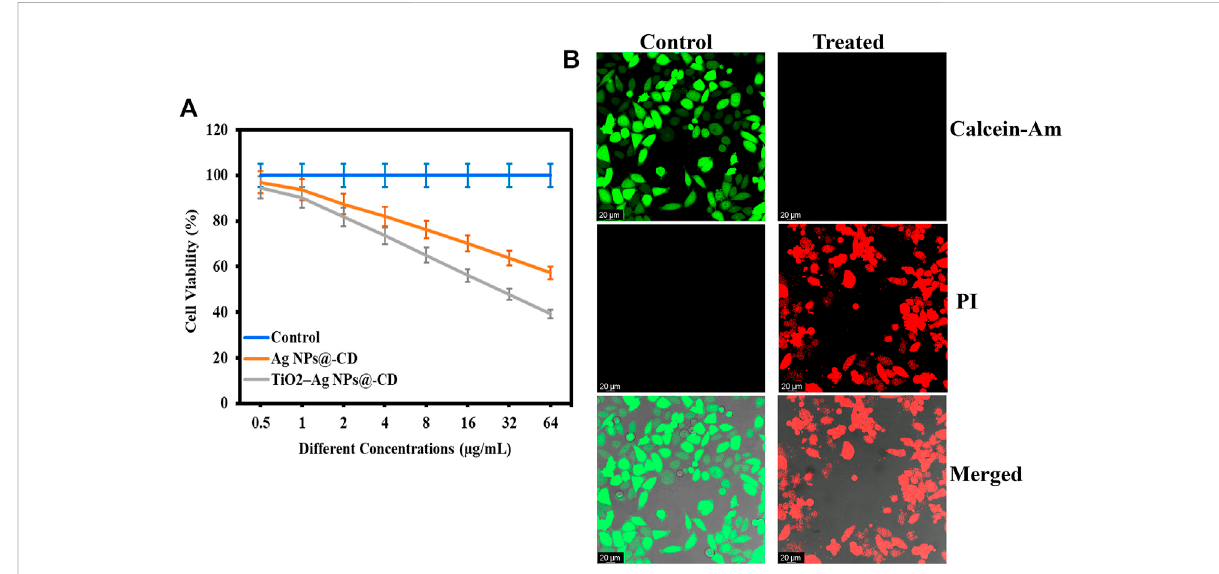
FIGURE 3 (A) Anticanceractivityintermsofcell viability (%)againstHeLacancercells. (B) Live/deadCLSMimages